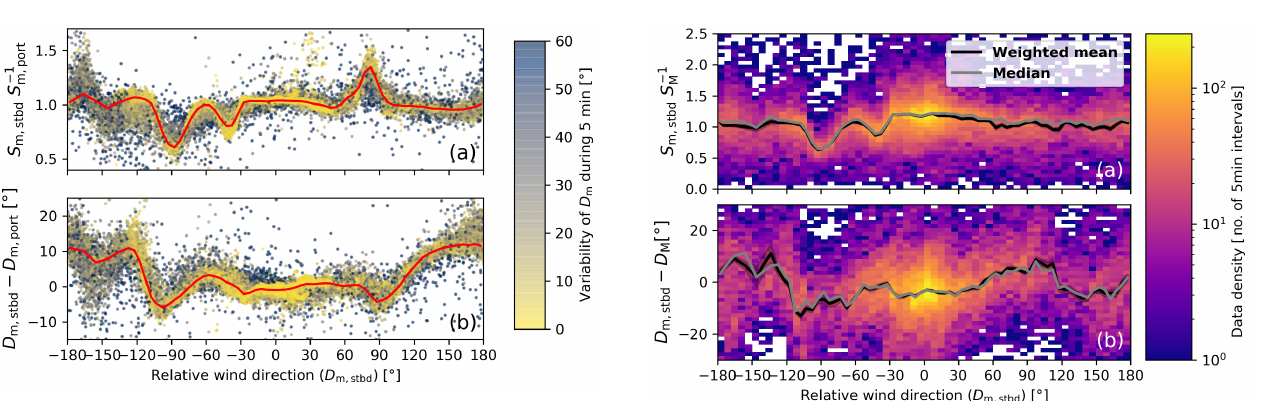
Figure 5. (a) Bi-dimensional histogram of S m , stbd S − 1 and M D m , stbd . The number of samples per ratio and the wind direction bin are shown as a heat map with a logarithmic colour scale. The black line shows the weighted arithmetic mean calculated over each wind direction sector. The grey line shows the median. Panel (b) is the same as (a) but for the relative wind direction